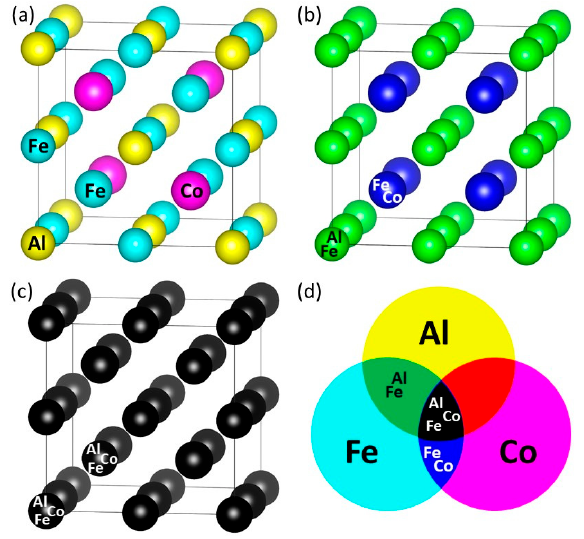
Figure 1. Schematic visualizations of atom configurations in Fe 2 AlCo: an inverse-Heusler ( a ), a partially ordered B2 ( b ) and a disordered A2 ( c ). A schematic of the used coloring of atoms ( d ).